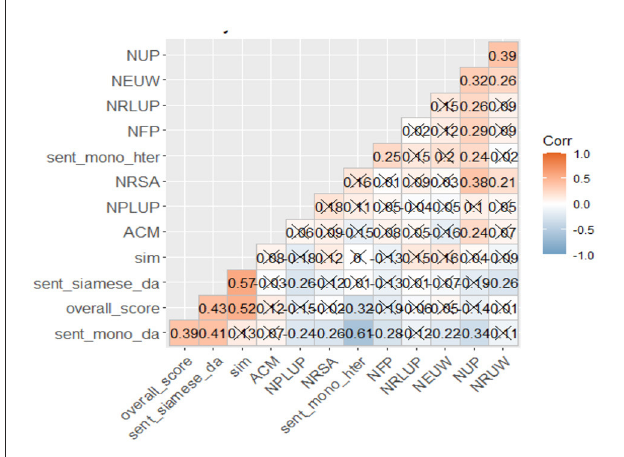
FIGURE6 Correlation matrix chart among temporal measures and scores computed by neural networks and overall human-assigned scores.